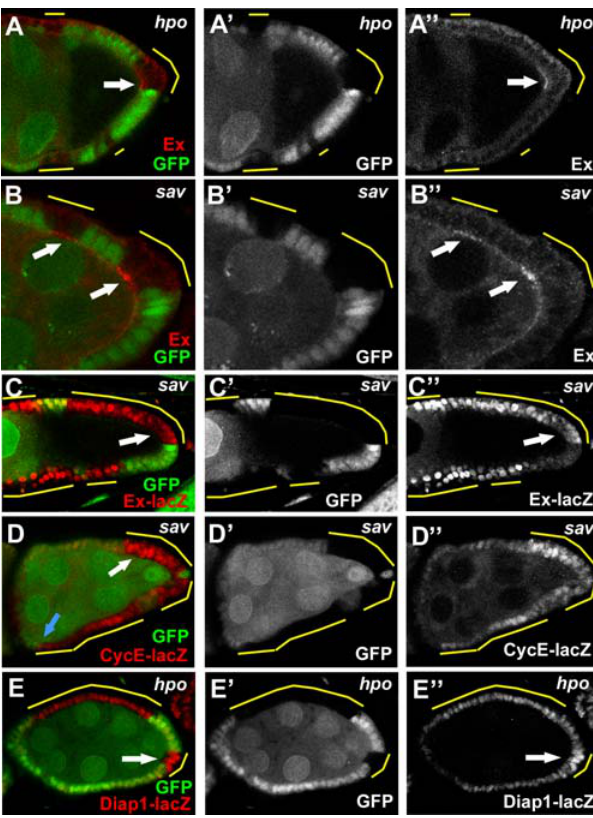
Figure 6. Expression of Hpo target genes in mosaic egg chambers. (A,B) Upregulated Ex expression was found in hpo (A) and sav (B) mutant follicle cells (arrows). Note that a stronger upregulation of Ex was found in the PFC clone (B). (C,D) Upregulated expression of lacZ markers for the Hpo pathway target genes ex (C) and cycE (D) was observed in sav follicle-cell clones (arrows). Note differences in expression of cycE-lacZ at boundaries between wildtype and clone cells at posterior (white arrow), as well as more anterior locations (blue arrow) in this stage 7 egg chamber. (E) In addition, diap- lacZ (arrow) was also upregulated in hpo PFC clones.